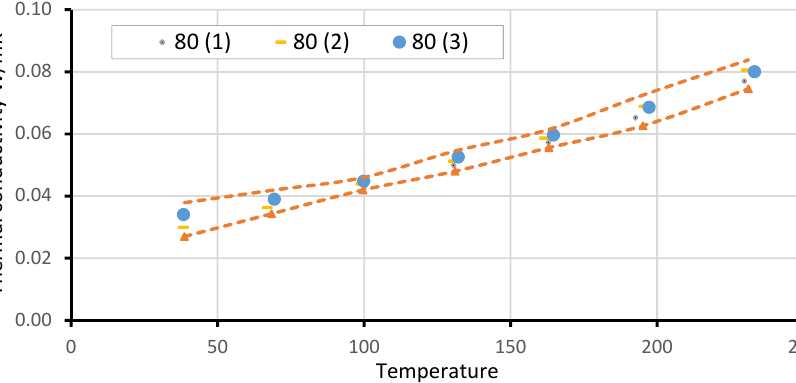
Figure 7. Dependence of the thermal conductivity coefficient (W/m°C) from the temperature (°C) for materials with densities of 80, 100, and 120 kg/m 3. Table 2. Values of the thermal conductivity coefficient for materials with densities of 80, 100, and 120 kg/m 3 for insulated surface temperatures in the range from 50 to 400 °C. Temperature of the Insulated Pipe, °C